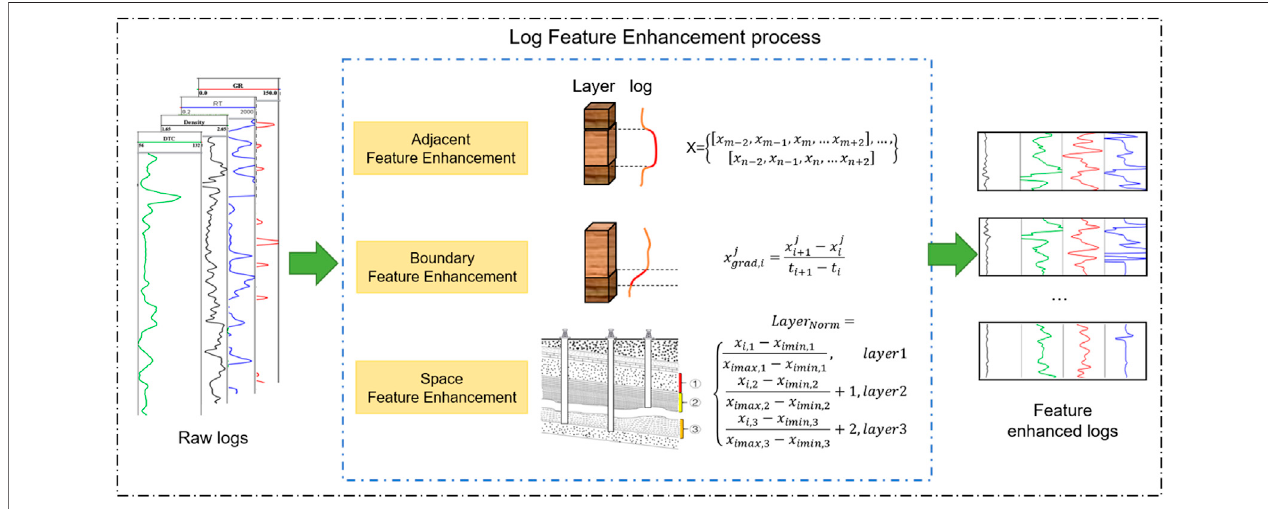
FIGURE 3 | The log feature enhancement process includes adjacent feature enhancement, boundary feature enhancement, and space feature enhancement.